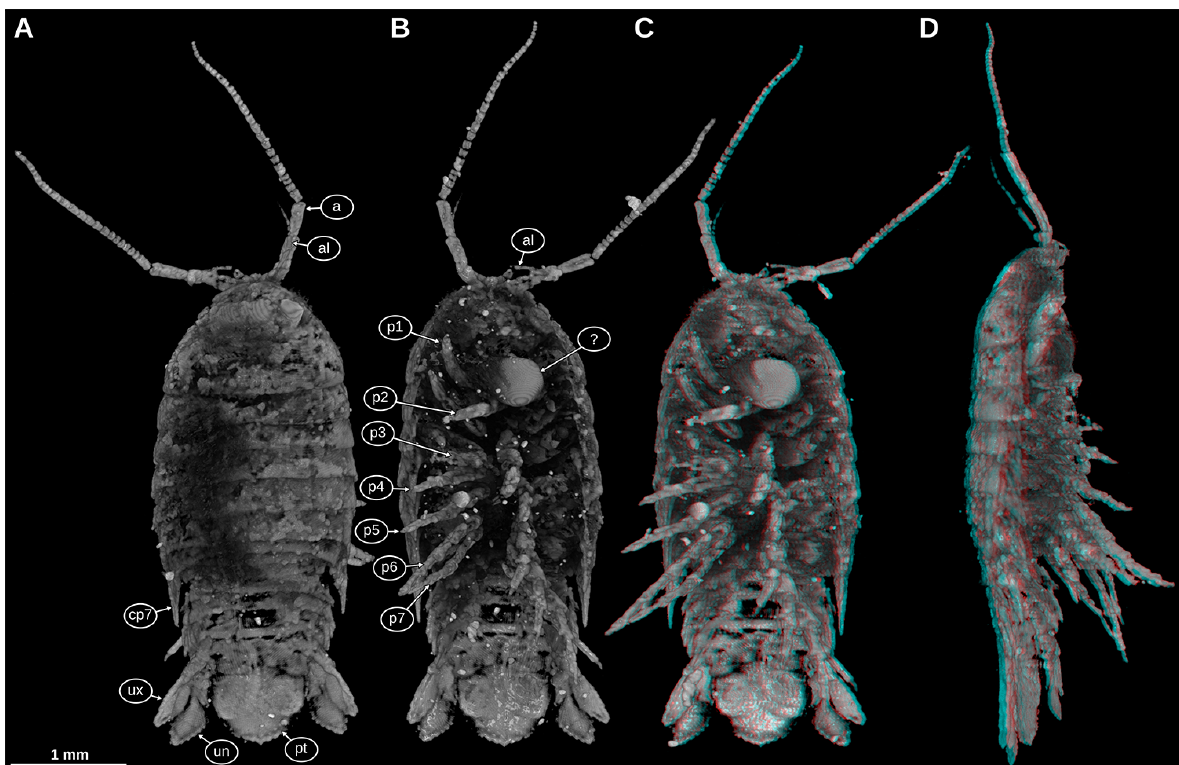
Figure 5: Holotype of Electrolana madelineae sp. nov. (NHMW 2017/0052/0001), volume rendering images based on micro-CT data. A : Habitus in dorsal view, orthographic projection; B : habitus in ventral view, orthographic projection; C : habitus in ventral view, red-cyan stereo anaglyph, perspective projection; D : habitus in lateral view, right body side, red-cyan stereo anaglyph, perspective projection. a, antenna; al, antennula; cp7, coxal plate of trunk segment 7; p1–6, trunk appendages 1–6; pt, pleotelson; un, uropod endopod; ux, uropod exopod; ?, unknown material forming an irregular